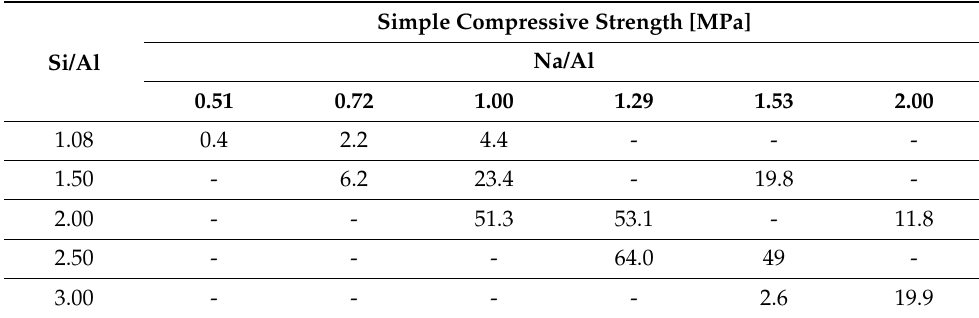
Table 2. Results of compressive strength at different ratios of Si/Al and Na/Al [65]. Simple Compressive Strength Si/Al